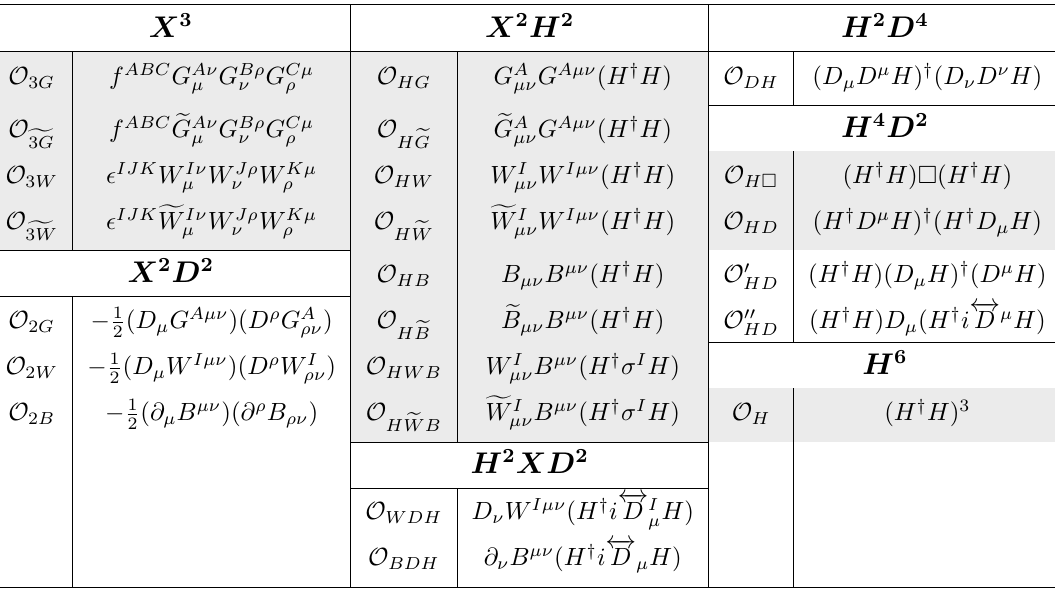
Table 7 . Bosonic operators in the Green’s